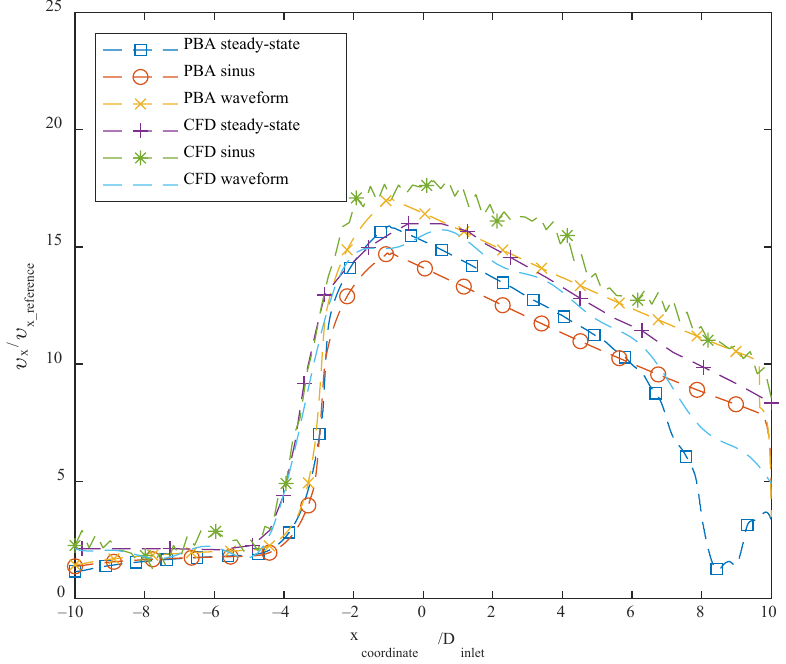
Figure 24. Residual histories for transient sinus ( a ) and waveform ( b ) with shape of FDA nozzle model.